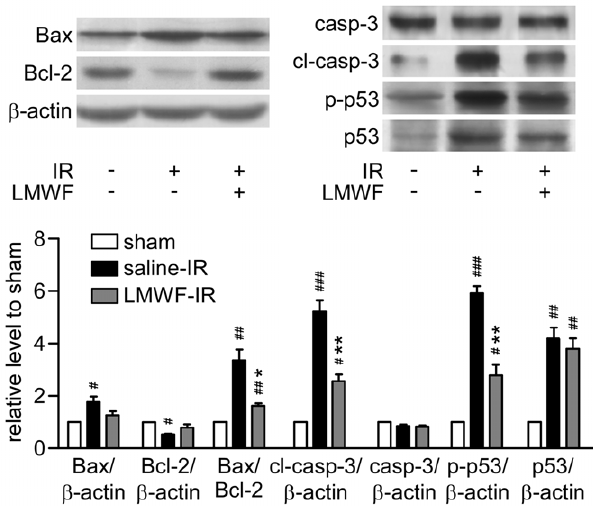
Figure 3. LMWF reduced cell apoptosis in kidney after IR. Protein expression levels of kidneys after reperfusion for 24 h were detected by Western blot analysis. Representative blotting ( up ) and quantification of protein levels ( down ) are shown. Mean 6 SEM. n=3; # P , 0.05, ## P , 0.01, ### P , 0.001 vs. sham, * P , 0.05, ** P , 0.01 vs. saline treated IR group.